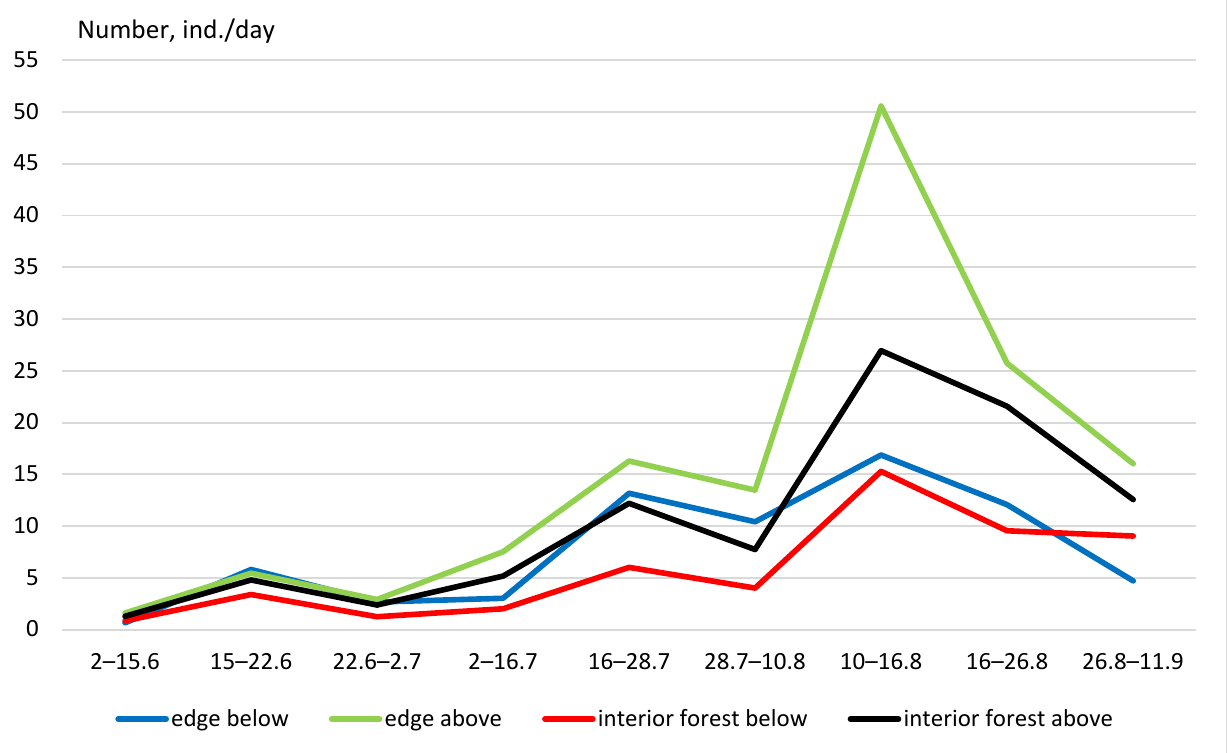
Figure 9. Seasonal abundance of Lepidoptera in edges and interior forest (at various heights).